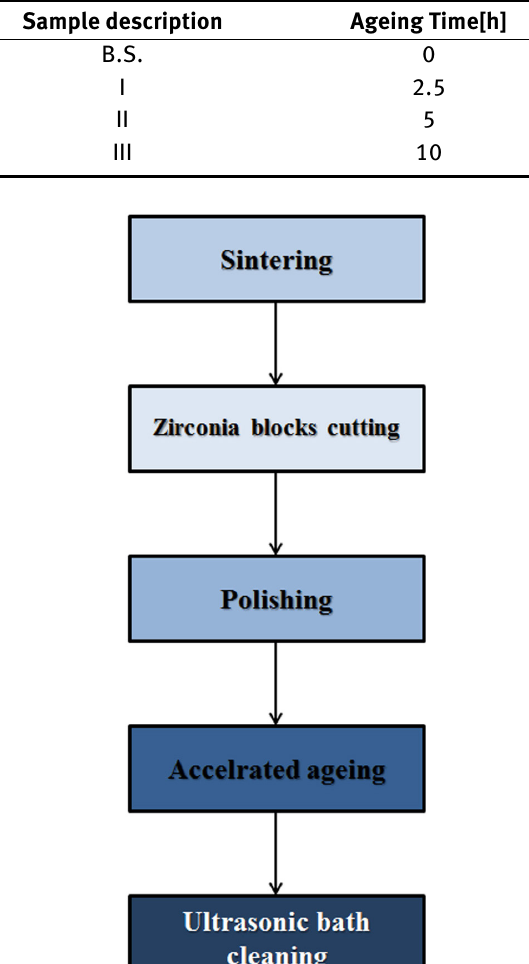
Figure 1: Schematic of laboratory stages.